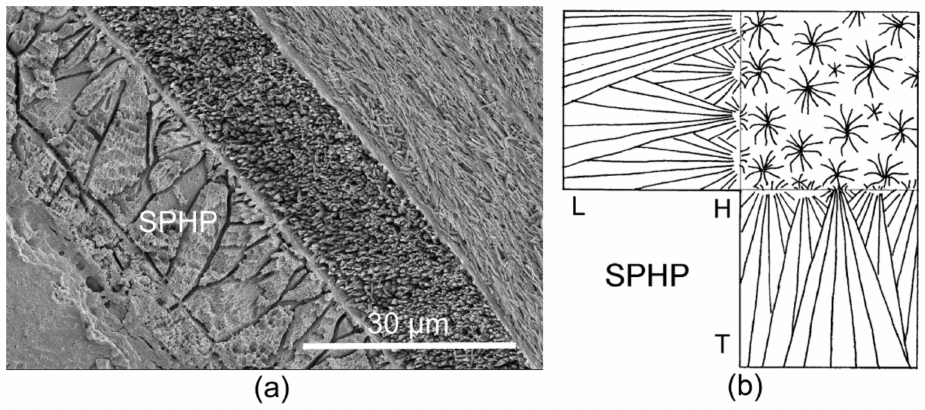
Figure 4. SPHP structure in the tube of Cruzigera websteri. ( a ) Transverse section, inner tube layer, polished and etched with acetic acid. ( b ) Schematic line drawing of the SPHP structure.